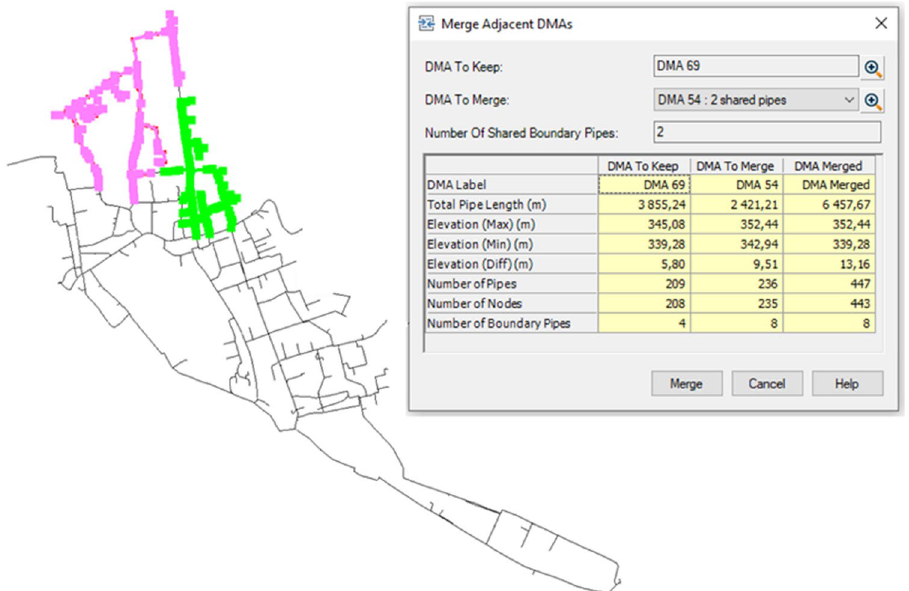
Fig. 6 Dialog box appearing while merging the areas 69 and 54 into a single area—DMA